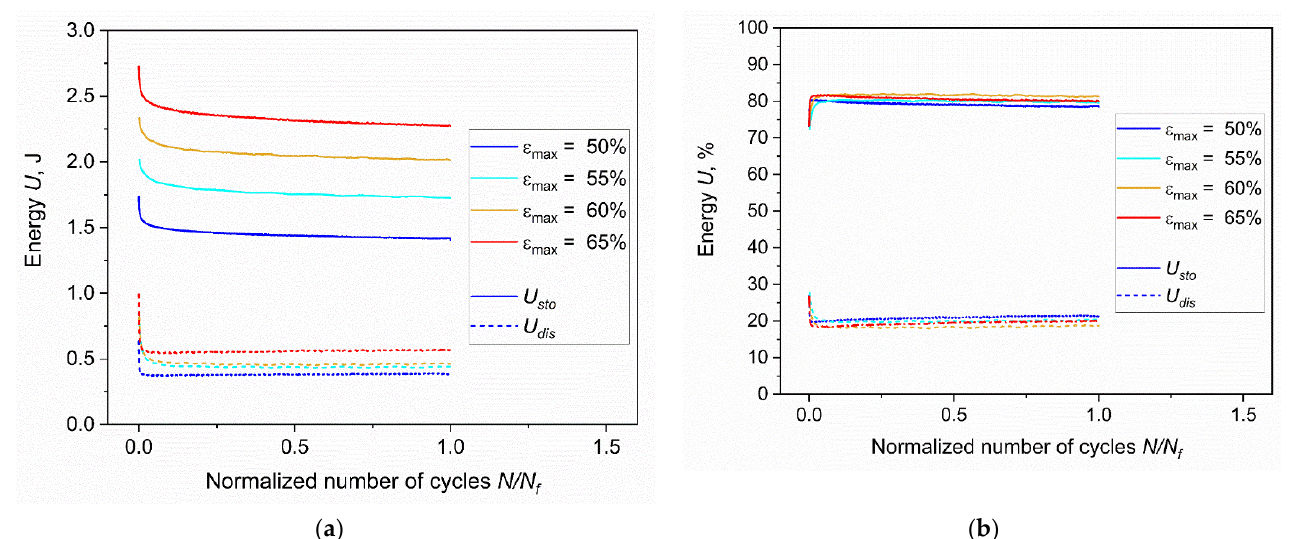
Figure 7. ( a ) Stored ( U sto ) and dissipated ( U dis ) energies at different strains against the normalized number of cycles; ( b ) percentage stored and dissipated energies at different strains against the normalized number of cycles. The fatigue tests were implemented on axisymmetric dumbbell specimens of CB filled NBR at a frequency of 4 Hz and a load ratio R ε of 0.5.